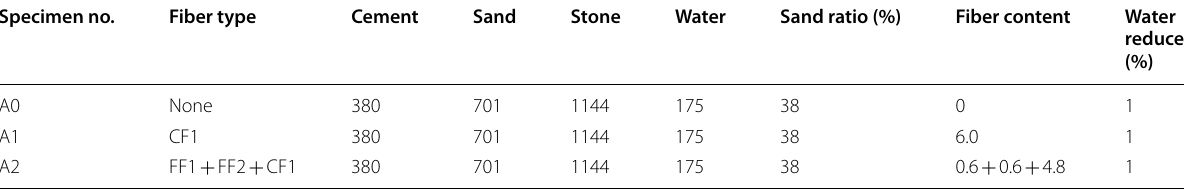
Table 2 Mix proportions of C30 concrete/(kg m − 3 ). Specimen no.